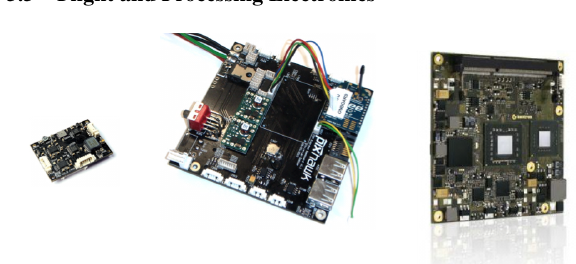
Figure 5: From left to right: Autopilot, image processing module, microETXExpress Core 2 DUO 1.86 GHz module.